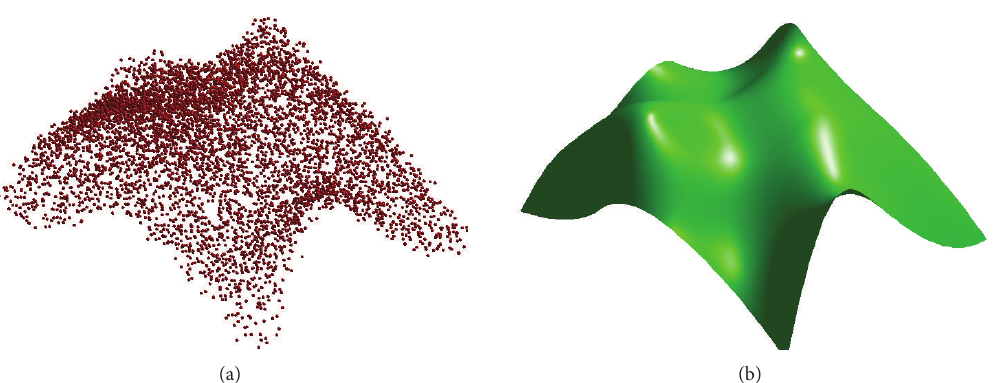
Figure 3: Applying the firefly algorithm to B´ezier surface approximation of data points: (a) original data points; (b) best approximating B´ezier